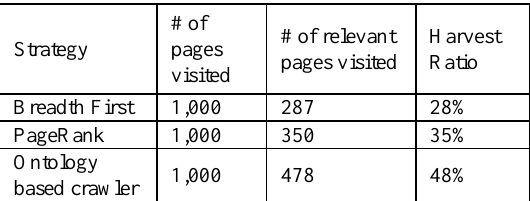
Table 2. Simulation results of different algorithm Strategy